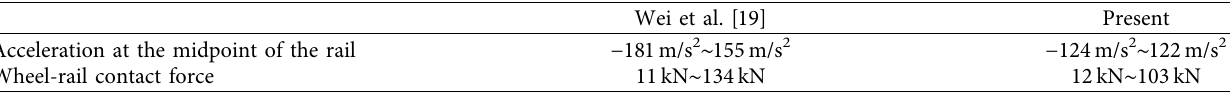
Figure 3: Vibration responses of the metro train-monolithic bed track system. (a) Vertical acceleration at the midpoint of the rail. (b) Wheel-rail contact force. Table 2: Comparison of vibration responses of the metro train-monolithic bed track